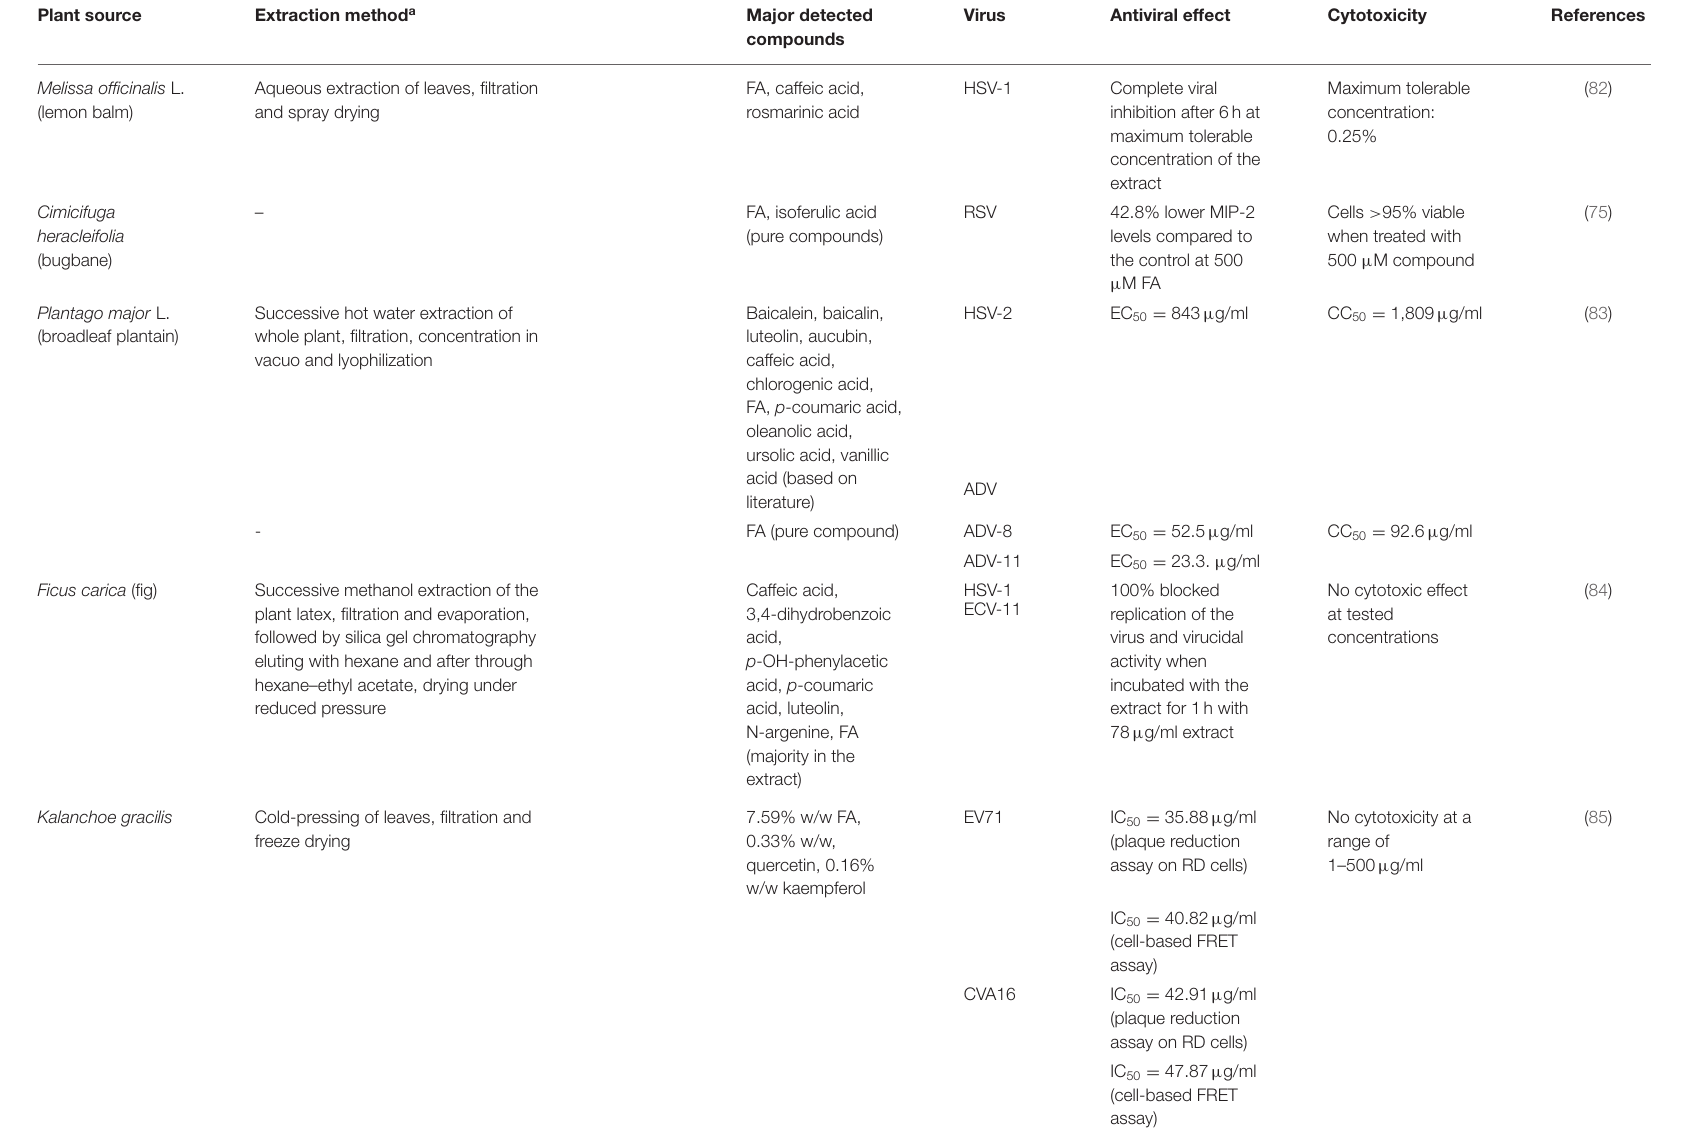
TABLE 2 | Antiviral effect of plant extracts containing FA.